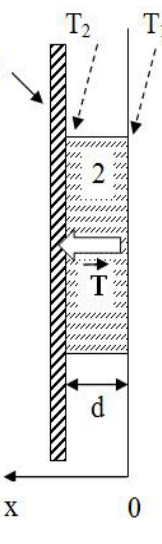
Figure 5. Graphical representation of the conditions of the boundary value problem to be solved, where 1 = the substrate collector of thermal energy; 2 = the film through which the heat flux passes; T 1 and T 2 = the film temperatures from the upstream side of heat flux and substrate; d = the thickness of the film; T=the direction of propagation of the heat front; x = the spatial coordinate (the normal to the platform through heat transfer which is carried out).